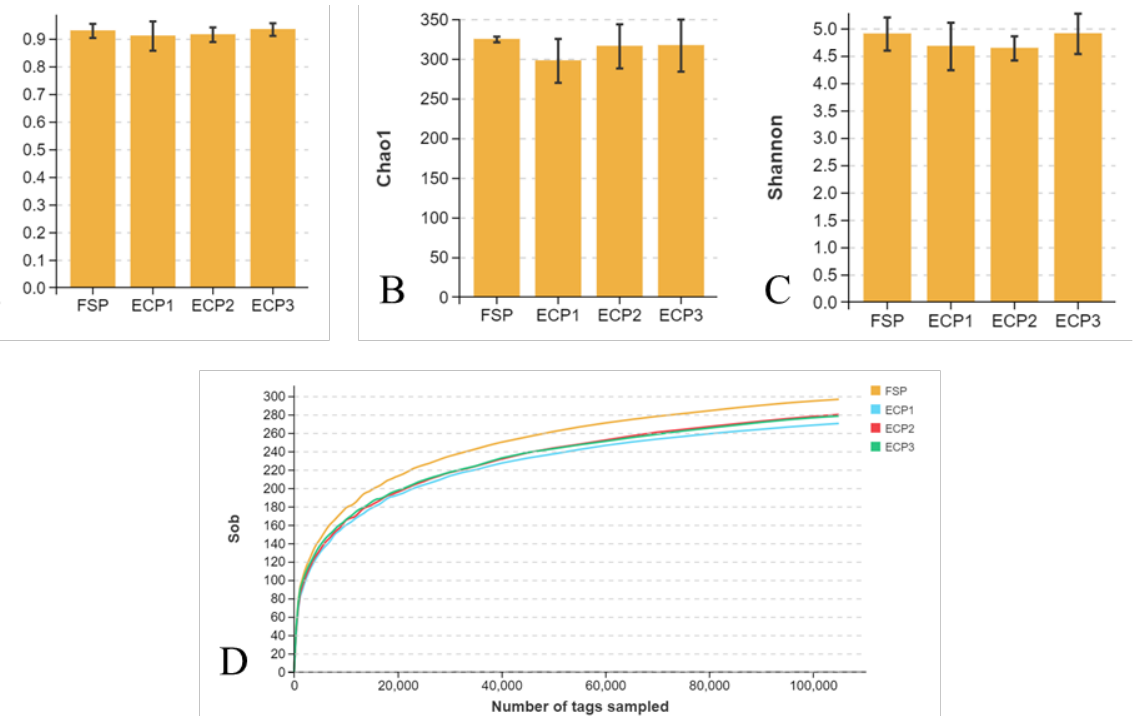
Figure 2. Alpha diversity of present study. ( A ) Simpson diversity; ( B ) Chao1 diversity; ( C ) Shannon diversity; ( D ) Rarefaction.